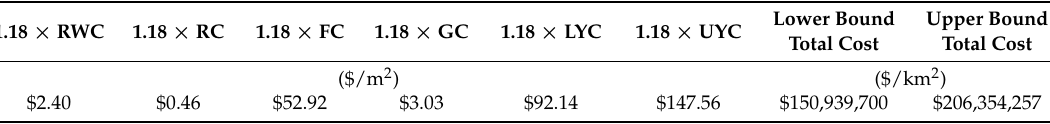
Table 9. Cost components and total cost (US dollars) to elevate and retrofit GenPort two